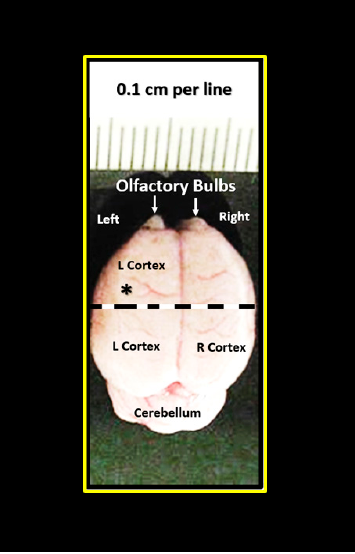
Figure 2. Photomicrograph of brain specimen for transmission electron microscopic studies. The left hemisphere was utilized for this study. Cortical gray matter tissue specimens were obtained just cephalad to the mid-cortex dashed line (asterisk). Scale = 0.1 cm. Brain measured approximately 1.4 ×